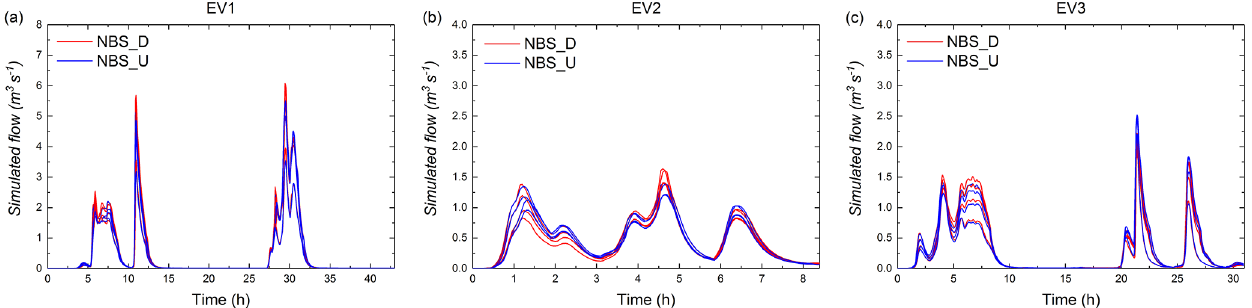
Figure 12. Simulated flow (cubic metres per second) of the first set of NBS scenarios under three distributed rainfall events and three uniform rainfall events (the red hydrographs represent the NBS scenarios simulated with distributed rainfall, and the blue hydrographs represent the NBS scenarios simulated with uniform rainfall), namely (a) EV1, (b) EV2, and (c) EV3.